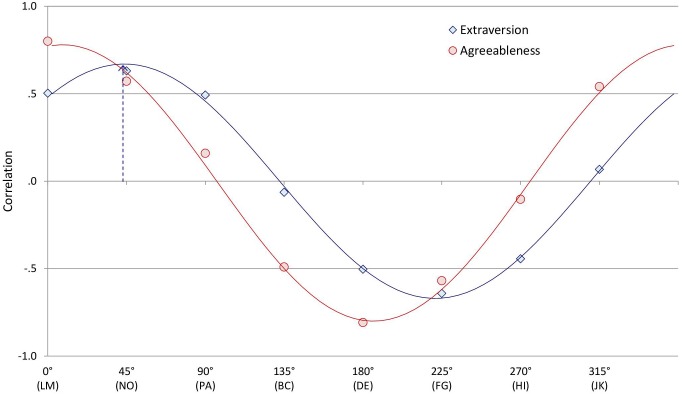
Circles and diamonds indicate the observed correlations between collective Agreeableness or Extraversion and each Circumplex Team Scan octant scale. Continuous lines show the best-fitting cosine curve for each profile of correlations. The arrow shows the vector sum of the profile of correlations with Extraversion.